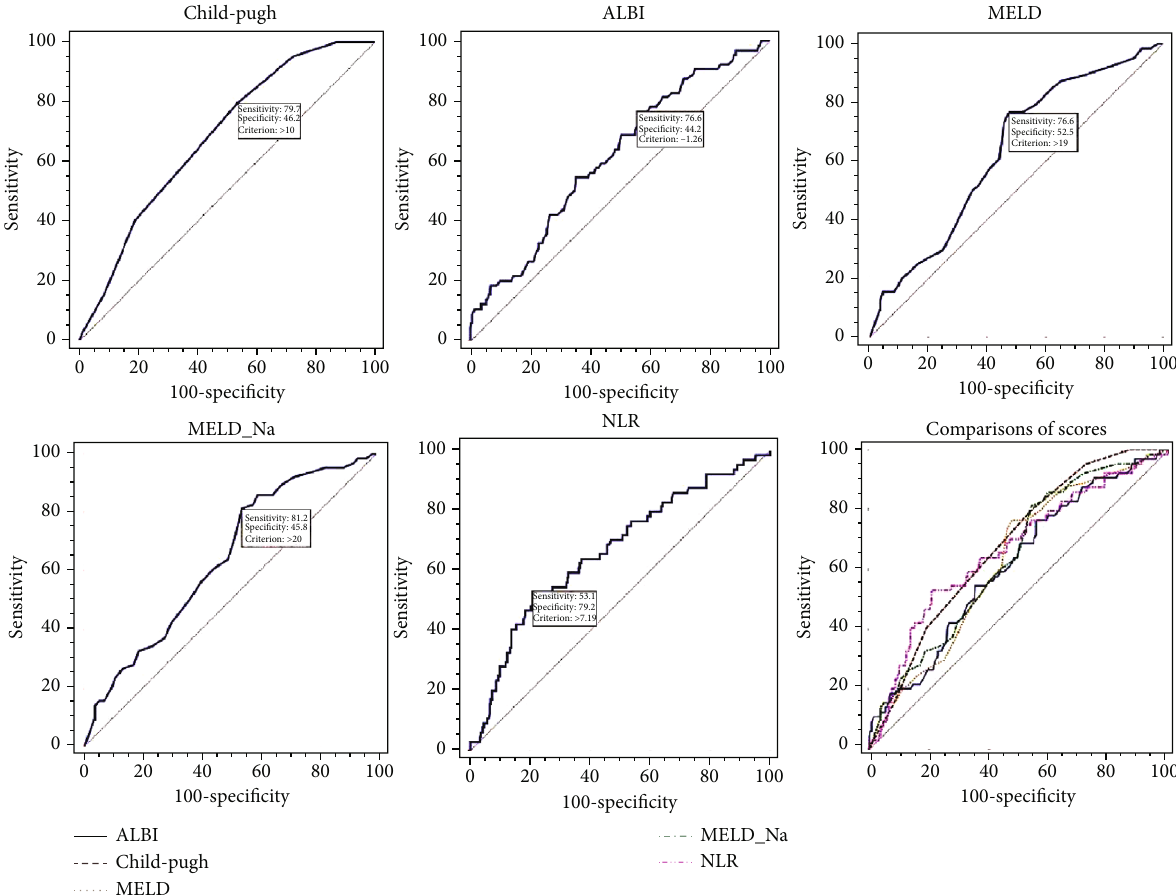
Figure 1: Comparisons of scores in the prediction of in-hospital mortality in the whole